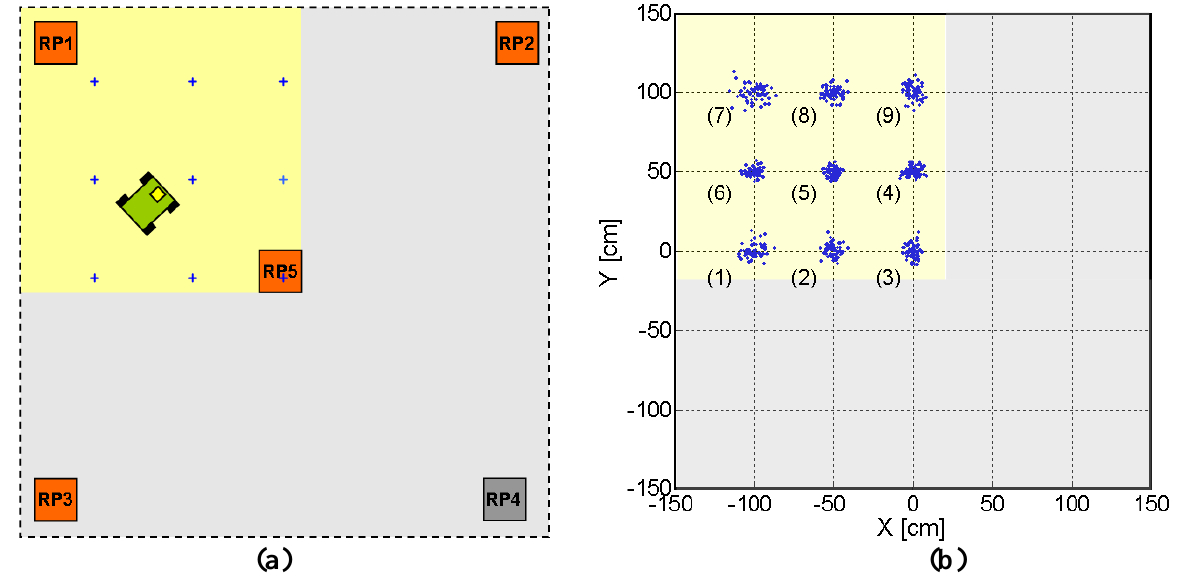
Figure 16. (a) Setup for position estimation; (b) Position estimation